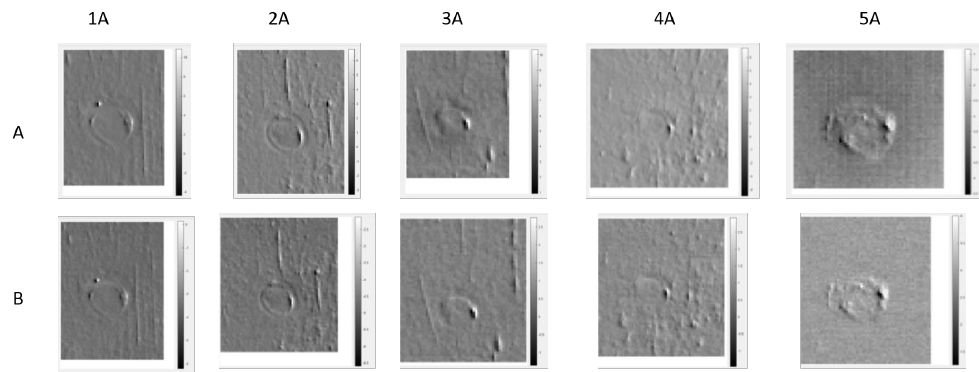
Figure 5. Images taken from the principle component analysis of the five samples during two experiments. The excitation frequency of experiment ( A ) is 0.05 Hz, and the frequency of ( B ) is 0.4